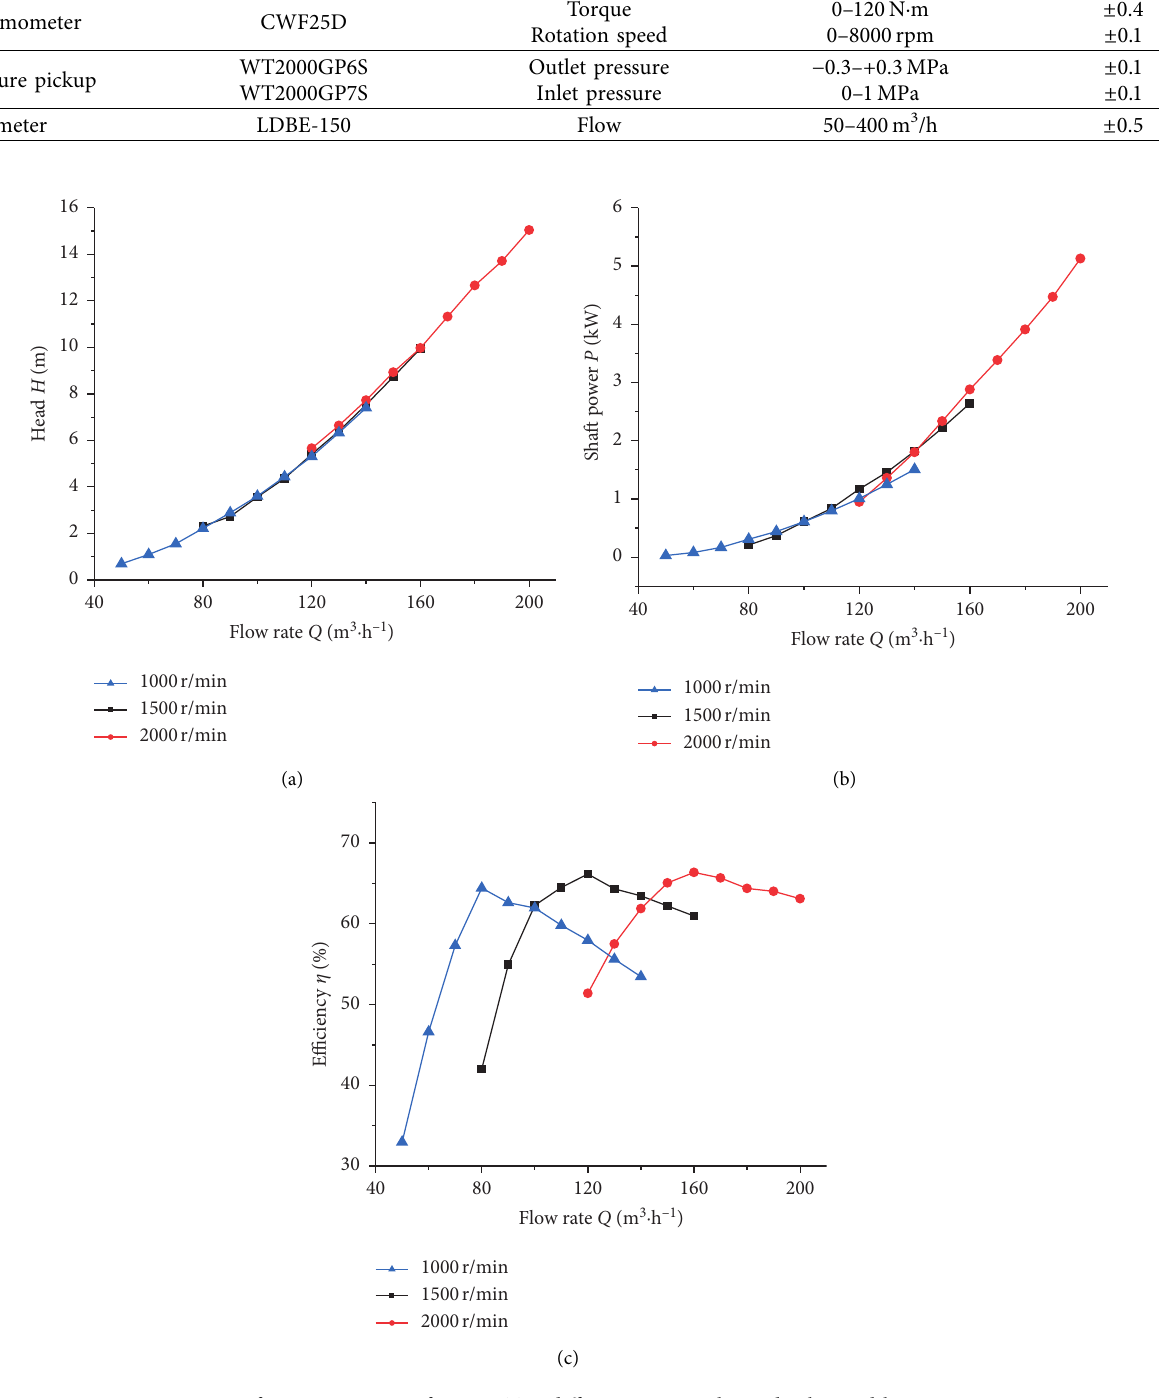
Figure 10: Performance curves of MF-PAT at different rotational speeds obtained by experiment. Table 5: BEP parameters by experiment at different rotational